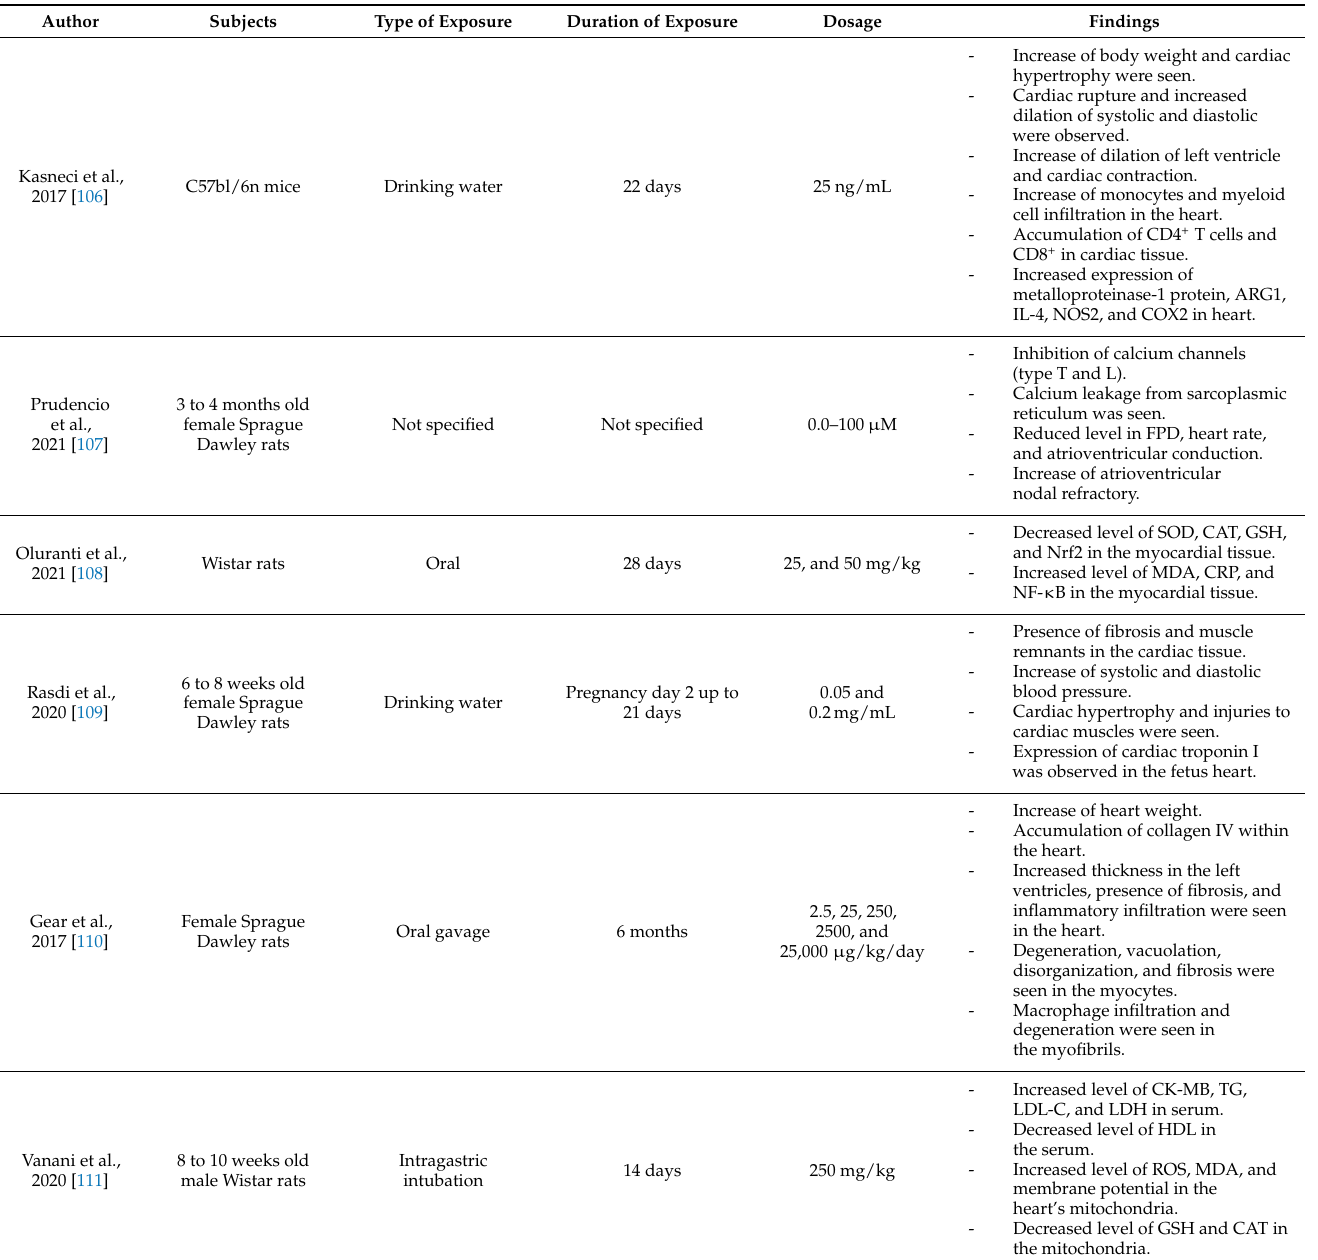
Presence of fibrosis and muscle remnants in the cardiac tissue. Increase of systolic and diastolic blood pressure. Cardiac hypertrophy and injuries to cardiac muscles were seen. Expression of cardiac troponin I was observed in the fetus